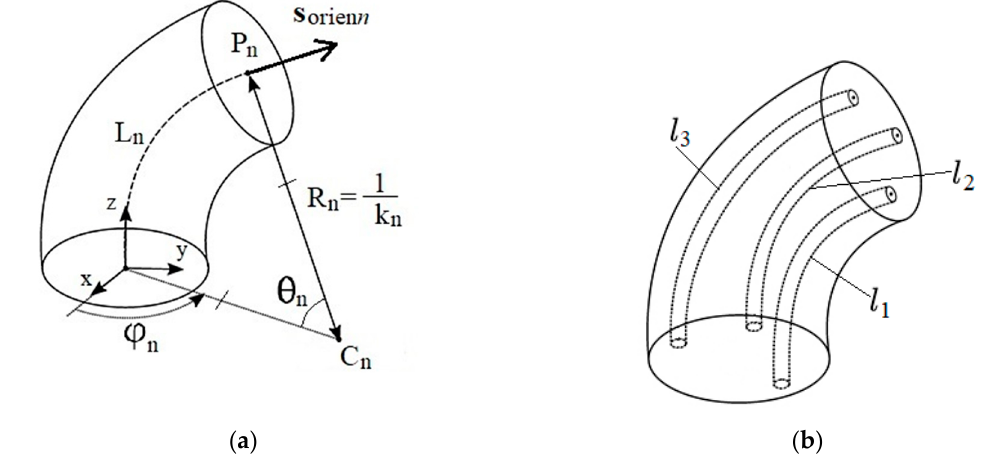
Figure 3. Continuum robot n-th segment parameters: ( a ) Robot n-th segment main parameters; ( b ) robot cables (tendons) view in one segment, robot cables lengths are (cid:1864) (cid:2869) , (cid:1864) (cid:2870) , (cid:1864) (cid:2871) .